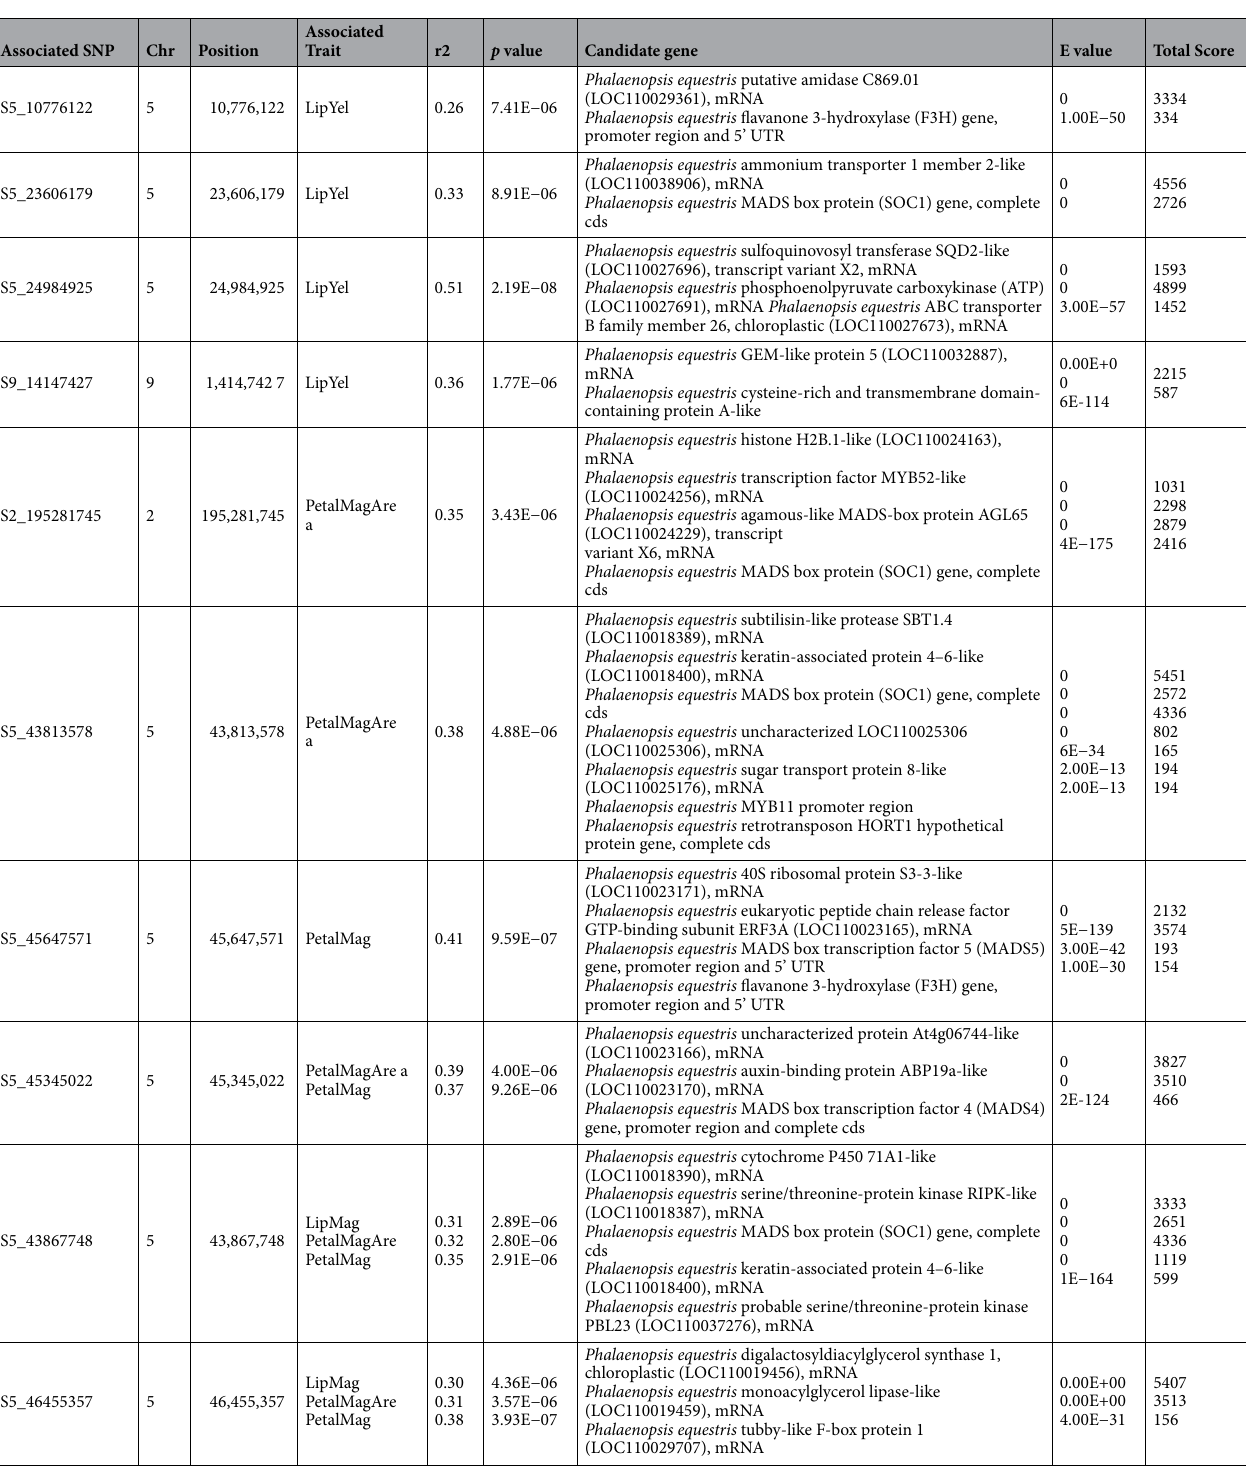
Table 2. Candidate genes located in the upstream and downstream region of linkage disequilibrium to trait- associated SNPs based on the NCBI